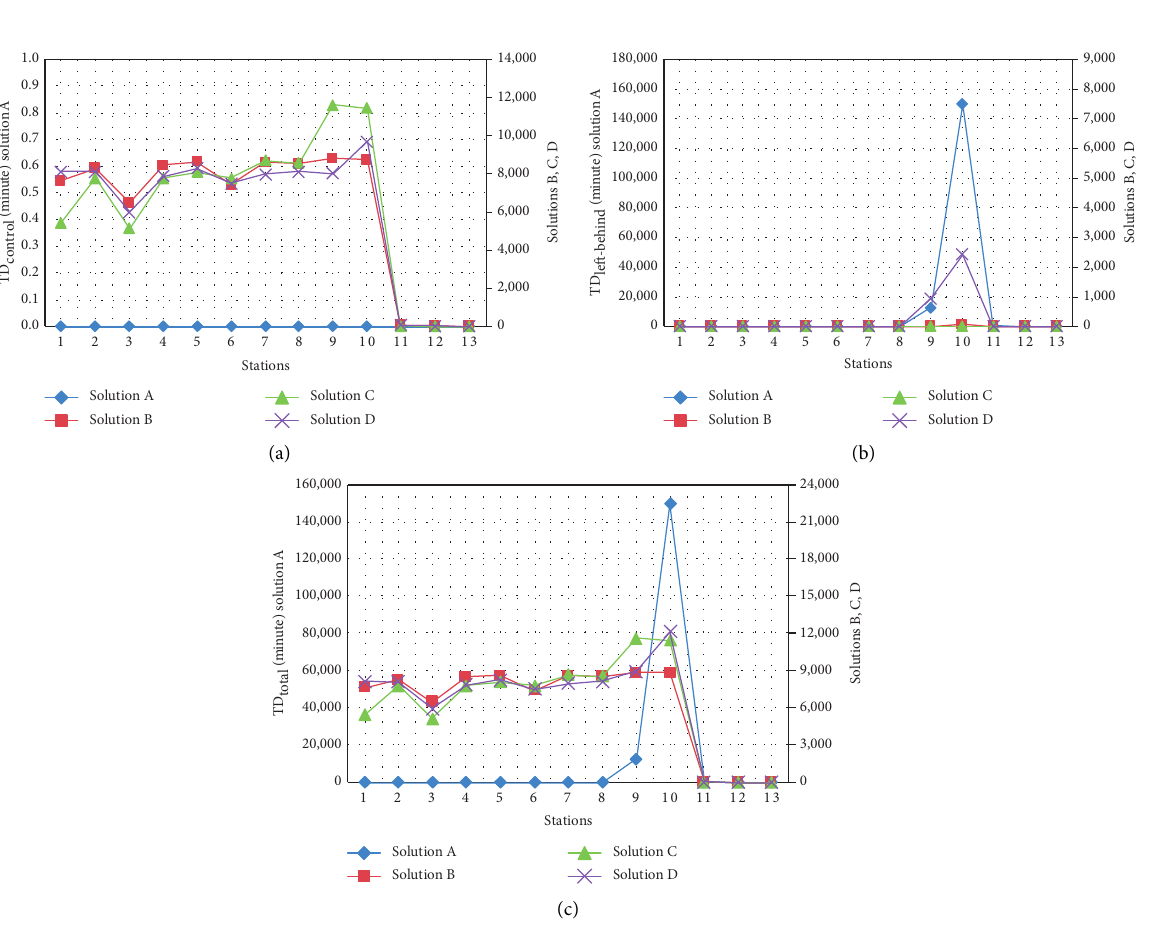
Figure 14: The delay indicators on each station of each solution. (a) Flow control delay. (b) Left-behind delay. (c) Total